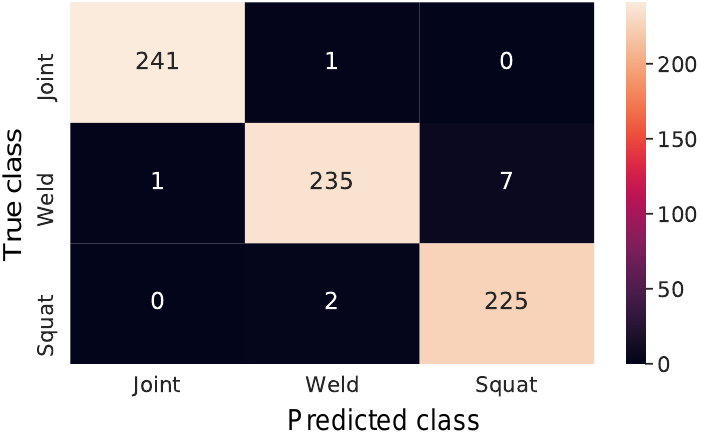
Figure 14. Classification confusion matrix.